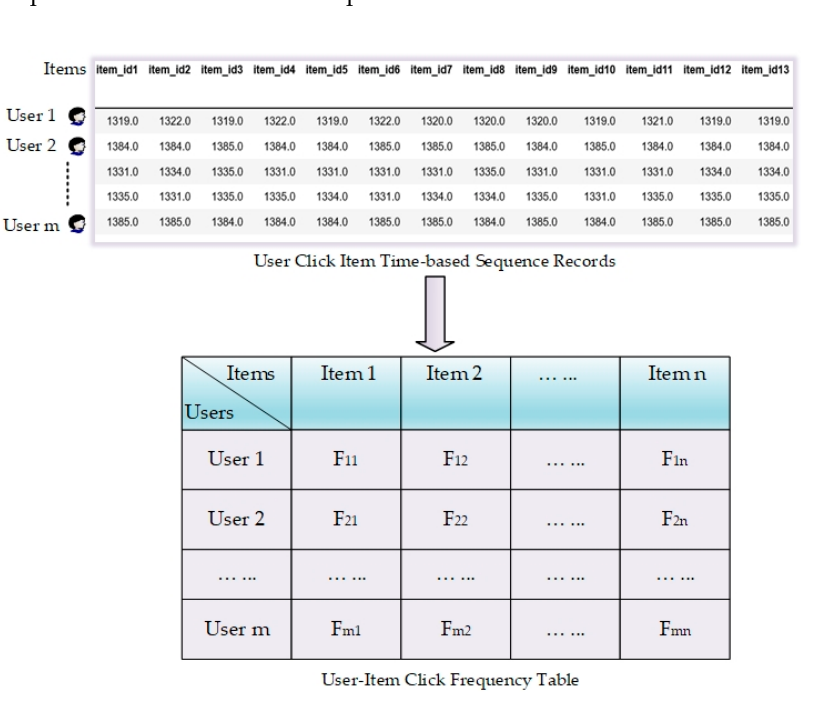
Figure 3. Frequency table of user–item